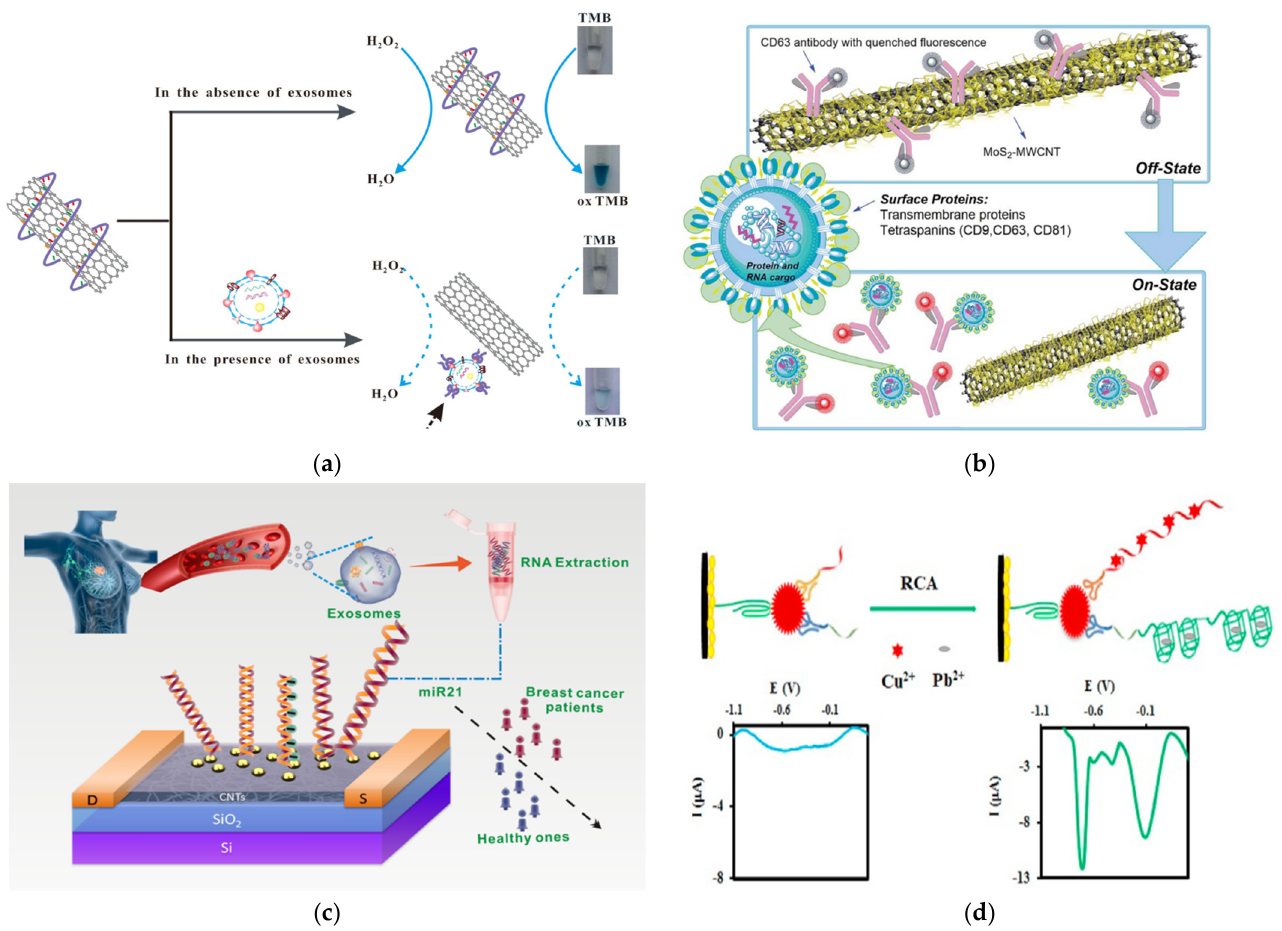
Figure 8. Exosome detection with CNTs. ( a ) Schematic of a colorimetric aptasensor based on DNA − capped SWCNTs for exosome detection. Reprinted with permission from ref. [173]. Copyright@ 2017 Elsevier B.V. ( b ) Schematic of the detection mechanism of a MoS 2 − MWCNT-based nanosensor for exosome detection and quantification. Reproduced from ref. [174] with permission from the Royal Society of Chemistry. ( c ) Schematic of the detection of exosomal miRNA21 using DNA-functionalized CNT FET biosensor. Reprinted with permission from [175]. Copyright {2021} American Chemical Society. ( d ) Schematic of an electrochemical aptasensor for the multiplexed detection of exosome biomarkers. Reprinted with permission from ref. [178]. Copyright@ 2017